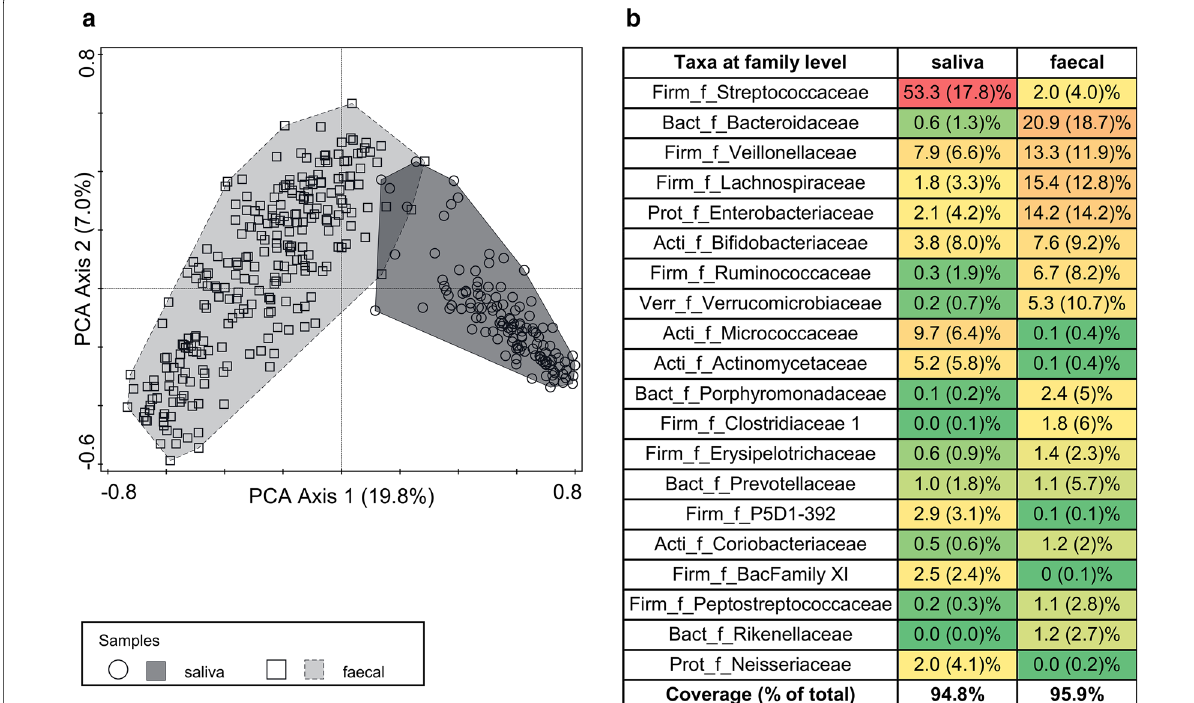
Fig. 1 Principal component analysis (PCA) of faecal and salivary microbiota composition ( a ) and summary of major bacterial families identified ( b ). The PCA sample scatterplot is displayed on the first two axes summarizing most of the species variation, which is based on the OTU count data for each sample. The distance between the sample symbols (rounds for saliva and squares for faecal) approximates the dissimilarity of their species composition as measured by their Euclidean distance. Mean relative abundances ( SD) are summarized at the family level (“_f_”) for taxa > 1% and ± summarized in the heat map (red–yellow–green color scheme indicating high to low relative abundance). Abbreviations used for bacterial phylum levels: Acti actinobacteria, Bact bacteroidetes, Firm firmicutes, Prot proteobacteria, Verr